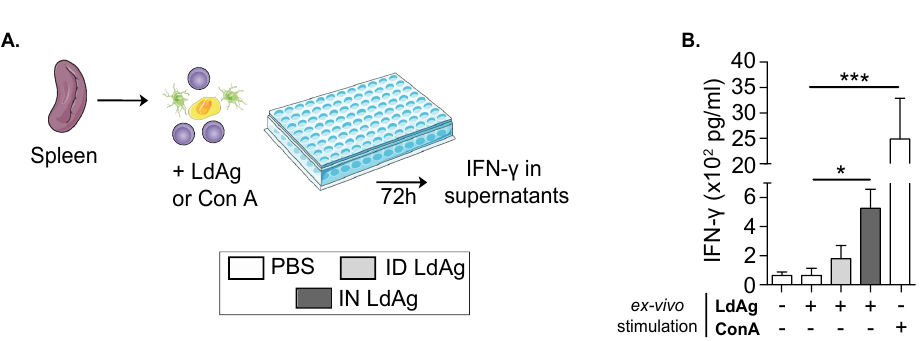
Fig 4. Ex-vivo stimulation of vaccinated mice splenocytes leads to IFN- γ secretion. (A) Spleens were processed to obtain single cell suspensions and incubated for 72 hours with LdAg or Con A to collect the supernatants. Images are from smart.servier.com. (B) Quantification of IFN- γ secretion by stimulated splenocytes via ELISA. Data are representative of two independent experiments and are presented as means ± SEM ( n = 4; one-way ANOVA).